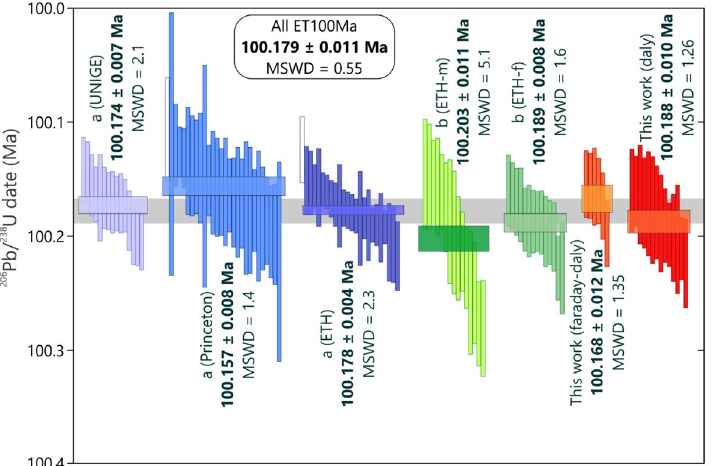
Figure 3. Compilation of ET100Ma solution 206 Pb/ 238 U apparent ages using the ET2535 spike (from a—Ref. 25 , b—Ref. 38 and this work). Blank boxes represent outliers not included in weighted mean age calculations. Different laboratories are discriminated in parenthesis, as well as Pb analyses measured by electron multipliers (m), Faraday cups (f), Daly photomultiplier (d) or a combination of methods (f-d). The grey bar through the middle of the plot is centered on 100.179 ± 0.011 Ma, which illustrates a ± 0.011% variation between laboratories.